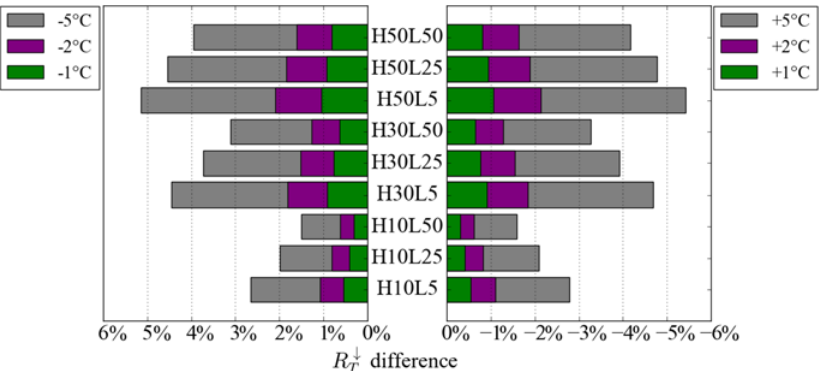
Figure 8. Differences in R ↓ with LST varying from − 5 to +5 ◦ C around the reference LST value, expressed as percentage of reference value